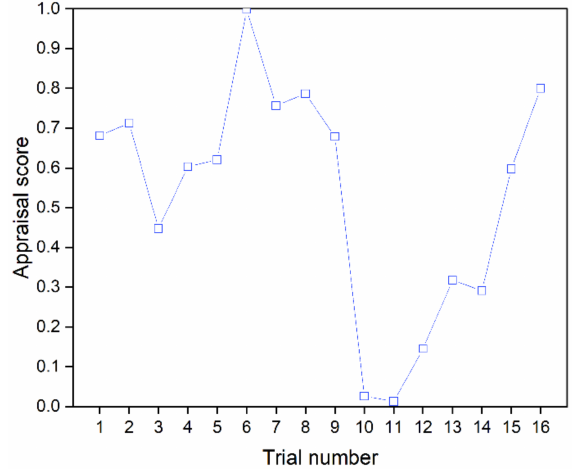
Figure 6. Appraisal scores in EDAS method for case study 1. In order to identify the optimal parametric combination for manufacturing brake lining materials using the VIKOR method, the corresponding values of R i and Q i indexes are calculated using Equations (21) and (22), respectively, for all the experimental trials. These values of R i and Q i are exhibited in Figure 7.